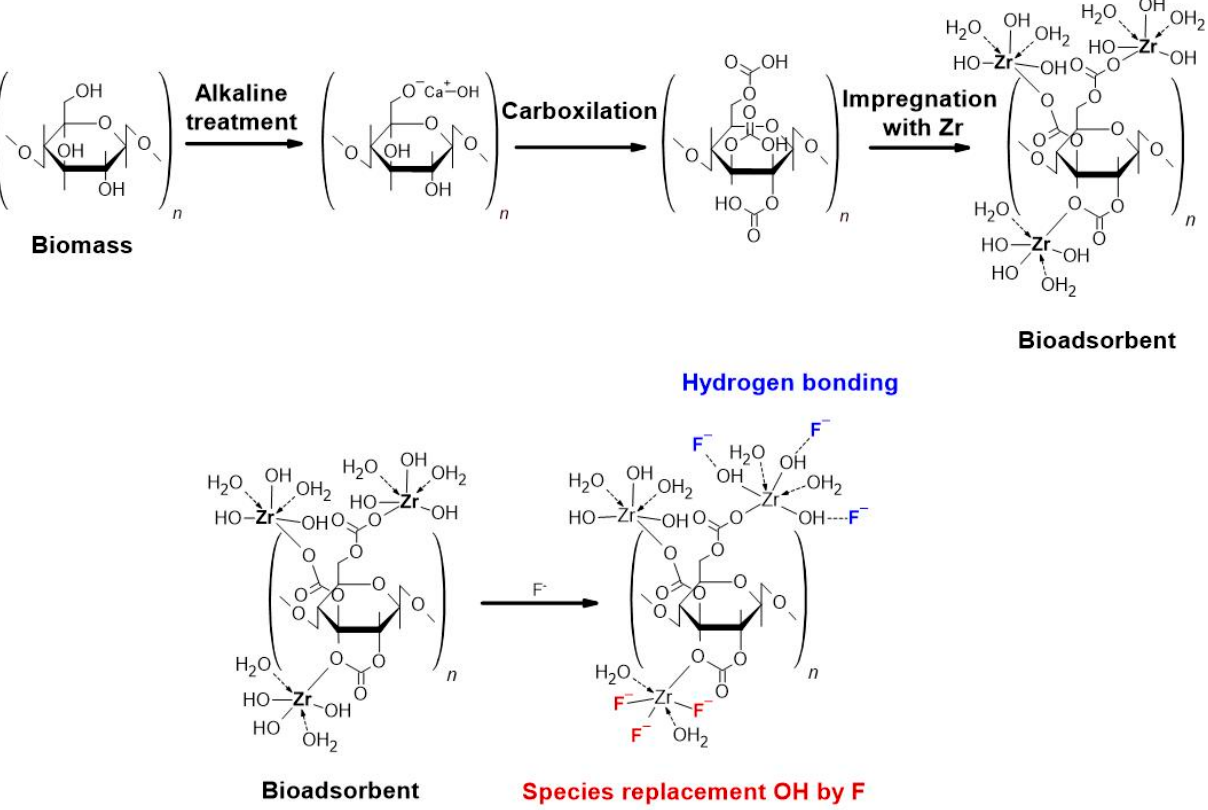
Figure 13. Synthetic route of zirconium loaded bioadsorbent and mechanism of fluoride adsorption.